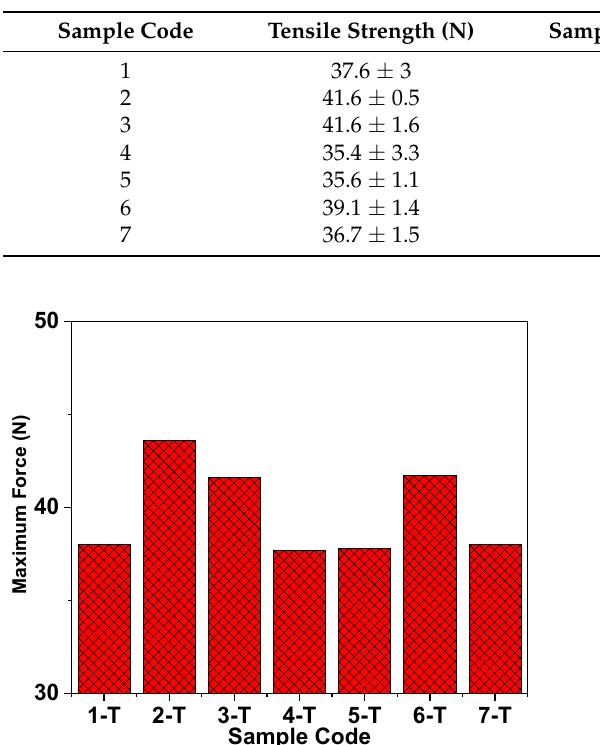
Table 2. Tensile properties data of the uncoated and developed coated cotton threads.